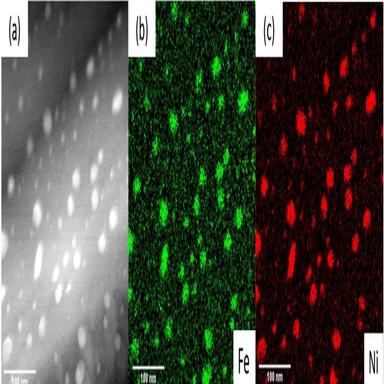
EDX mapping of a TEM micrograph on the TiAl grain showing compositions and distributions of the nano-precipitates on the grain. (a) TEM micrograph of a TiAl grain showing white "dots" distributed throughout, (b) Distribution of the iron element on the grain where "green" indicates the presence of iron, and (c) Distribution of nickel element on the grain where "red" indicates the presence of nickel.